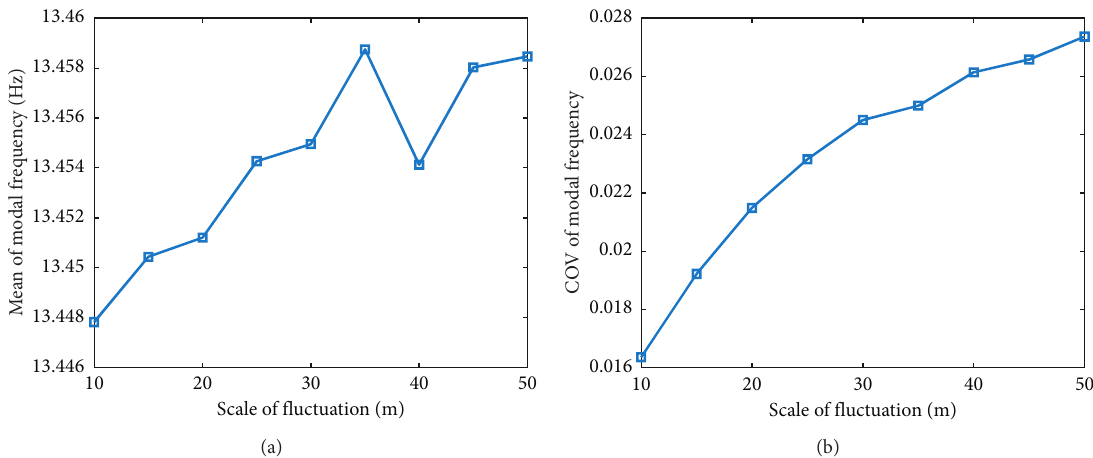
Figure 15: Statistics of the first-order modal frequency for different scales of fluctuation: (a) mean and (b) COV. The mesh size is 4 times the reference size.